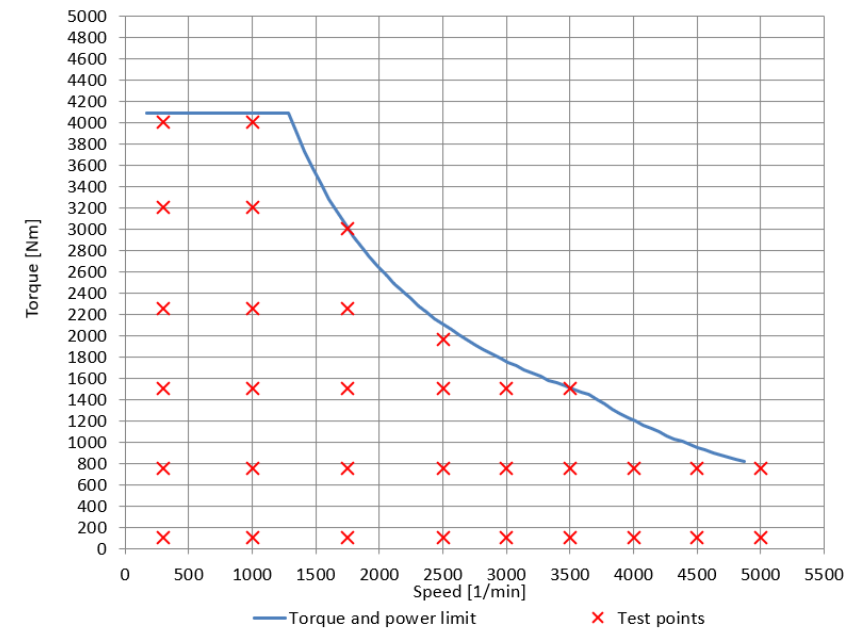
Figure 1. The example of a proposal of measuring